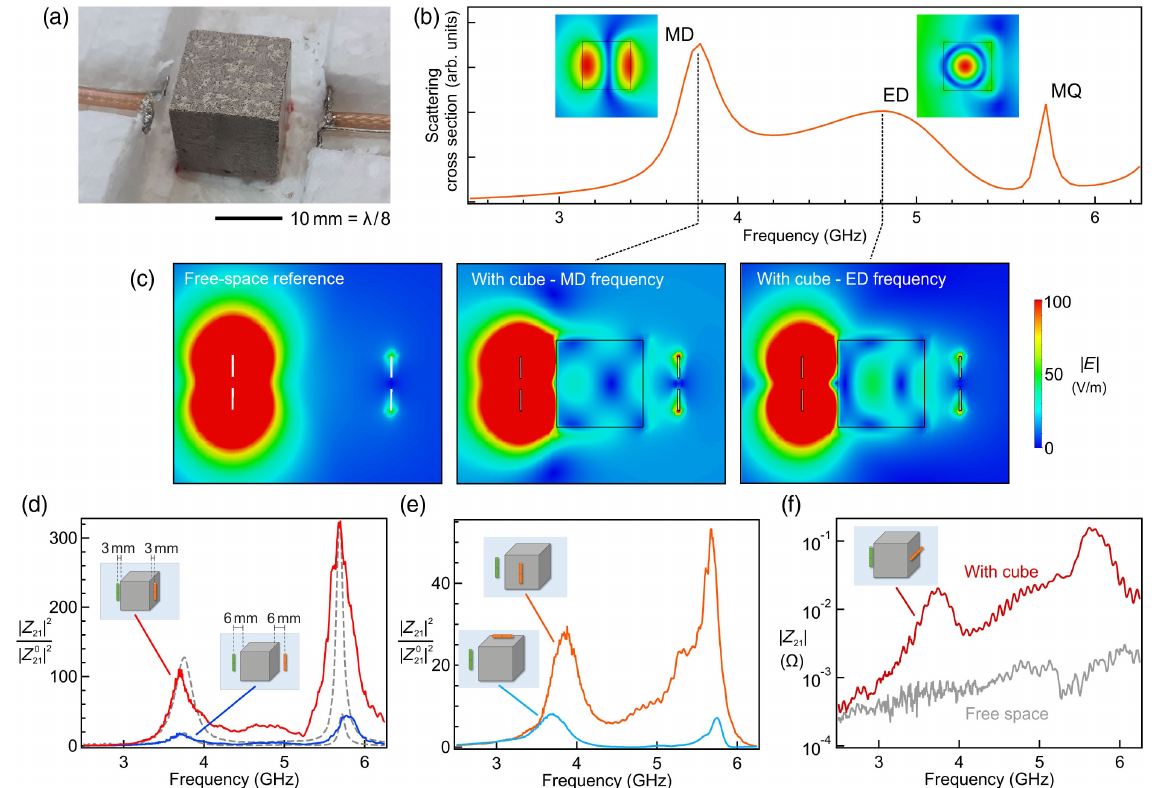
FIG. 4. Dipole-dipole interaction mediated by a dielectric cube scatterer. (a) Schematic of the experiment: the source dipole is on the left, the receiving dipole is on the right, and a 16 mm cube of dielectric permittivity 16 is placed between them. The distance between the dipole and the surface of the cube is 3 mm ( λ = 26 ) or 6 mm ( λ = 13 ). (b) Numerical simulations of the scattering cross section; the magnetic dipole (MD), electric dipole (ED), and magnetic quadrupole (MQ) resonances are clearly visible. The insets show the electric field amplitude at the MD and ED resonance frequencies, respectively, for plane wave illumination incoming from the left. (c) Numerical simulations of the electric field amplitude in the presence and absence of the dielectric cube at the MD or ED resonance frequencies. The dipoles are placed 6 mm from the cube. (d) – (f) Measurements of the FRET enhancement for different configurations. In (d) the dipoles are parallel and on opposite faces of the cube with 3 and 6 mm distances to the cube, respectively. The gray dashed lines show the result of numerical simulations. In (e) the dipoles are on adjacent faces of the cubes with 6 mm distance. In (f) the dipoles have a perpendicular orientation to each other. The dipole distance to the cube surface is again 6